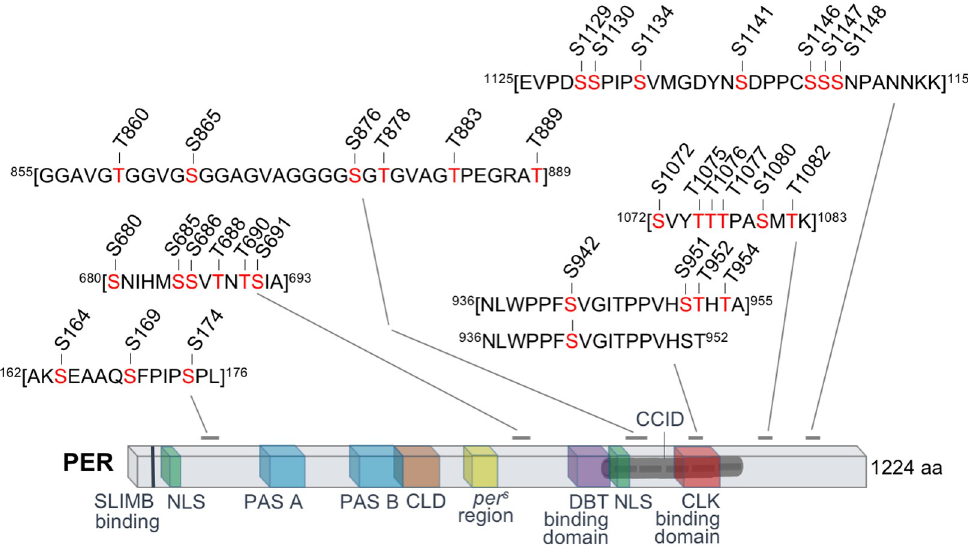
Fig 1. MS proteomic analysis identifies Drosophila PER O-GlcNAcylation sites. PER O-GlcNAcylation sites mapped onto PER coding region. Peptide sequences within square brackets include potential O-GlcNAc-modified residues (highlighted in red). Previously characterized functional domains include SLIMB binding site (pS47) [17]; PAS-A (aa240- 293) [33, 34]; PAS-B (aa 365–454) [33, 34]; per s region (aa585-601) [35]; Cytoplasmic Localization Domain (CLD) (aa450- 513) [31]; dCLK:CYC Inhibition Domain (CCID) (aa764-1034) [31]; Nuclear Localization Sequence (NLS) (aa814-840) [31]; DBT Binding Domain (DBT BD) (aa755-809) [36]; CLK Binding Domain (CBD) (aa926-977) [32]. Corresponding Mascot scores of modified peptides are presented in Table